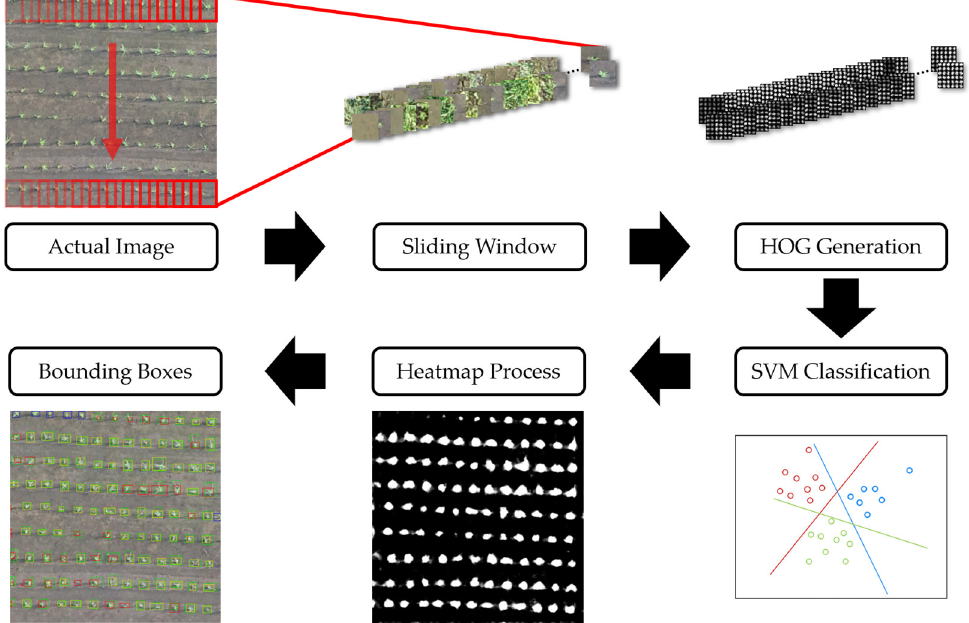
Figure 9. A diagram of rice seedling detection based on HOG and